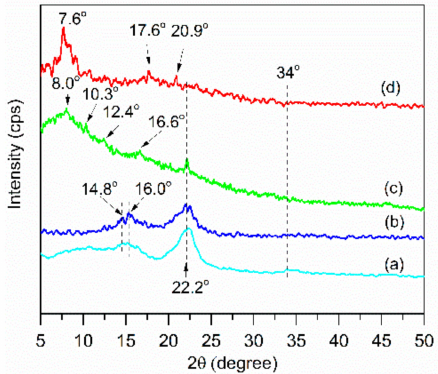
Figure 4. XRD patterns of extracted cellulose and CA samples synthesized from SB cellulose: ( a ) CE-1, ( b ) CE-2, ( c ) CA-1, ( d )